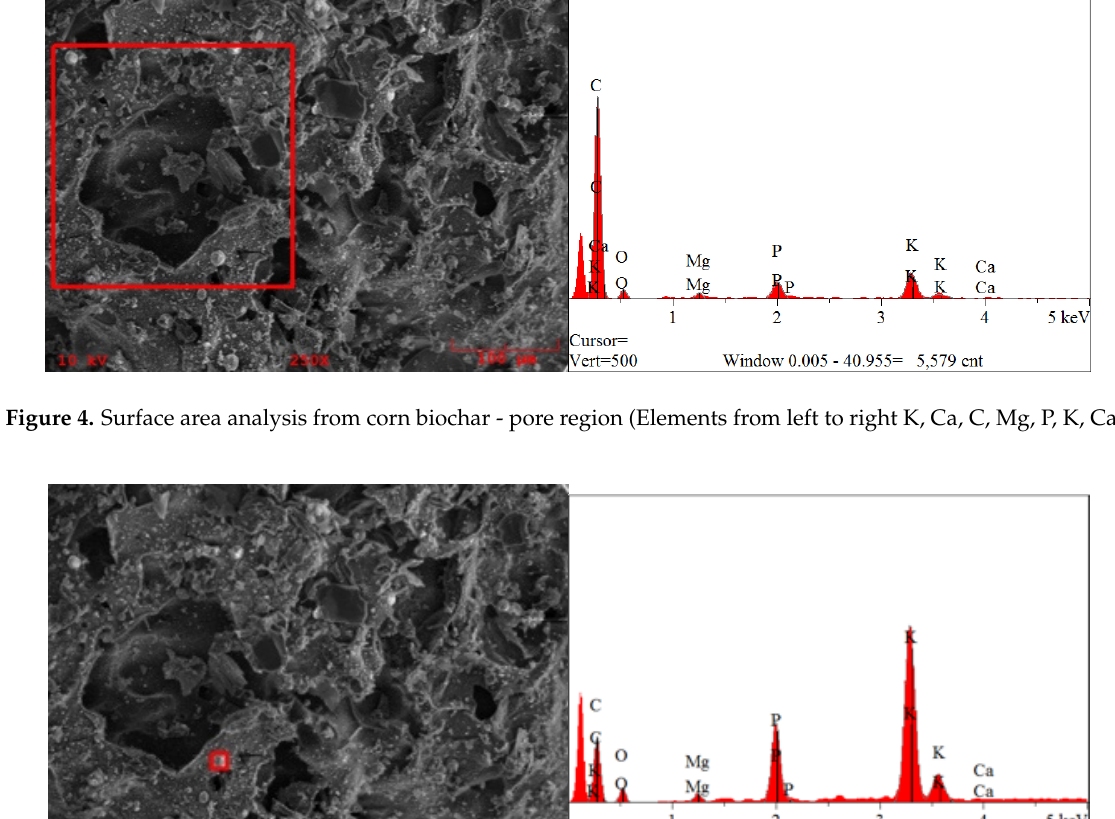
Figure 5. Surface area analysis from corn biochar- mineral spot (Elements from left to right K, C, Mg, P, K, Ca). Further corn surface areas were examined, particularly at porous regions, and surfaces next to them. As shown in the Figure 6 below, high contents of potassium and phosphorus were found, 41.2% and 16.95%, respectively. Additional traces of minerals such as magne- sium, aluminum, and silicon were found but at relatively lower concentrations. Figure 6 examines the concentration of minerals within a 30-micron surface in about 60-micron porous region on the surface on corn biochar. Traces of magnesium, aluminum, and silicon were found to be under 4%. In Figure 6, even though the peaks of phosphorus